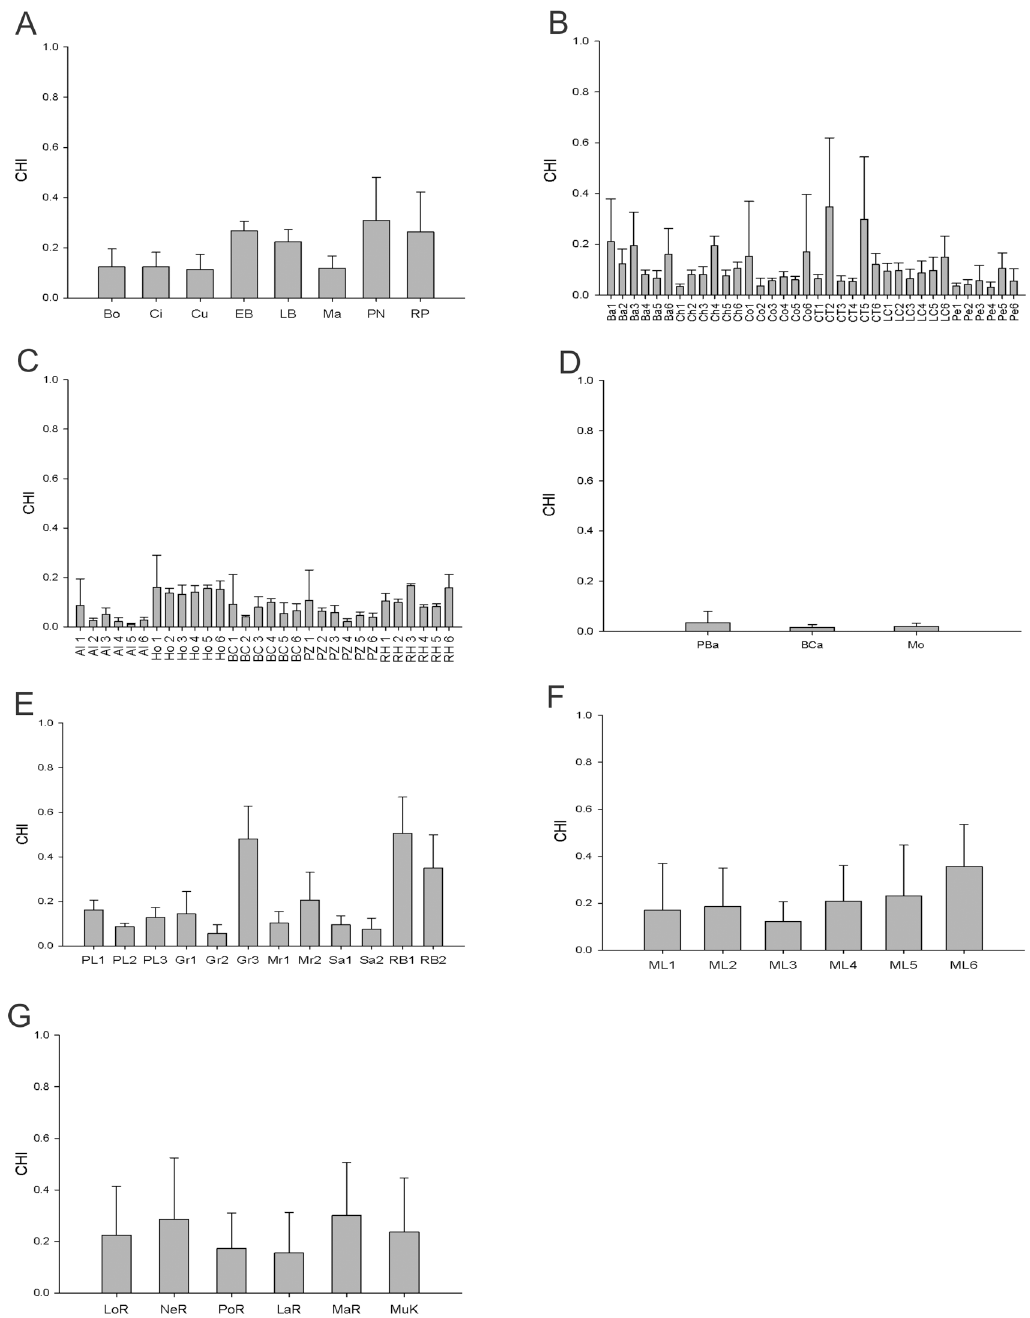
Fig 3. Coral reef health in sampling sites evaluated with CHI. a) Cancun: Bonanza (Bo), Chitales (Ci), Cuevones (Cu), El Bajito (EB), La Bocana (LB), Manchones (Ma), Punta Nizuc (PN), Radio Pirata (RP); b) Banco Chinchorro: Six sites for Baliza (Ba1, Ba2, Ba3, Ba4, Ba5, Ba6), six sites for Chancay (Ch1, Ch2, Ch3, Ch4, Ch5, Ch6), six sites for Colorados (Co1, Co2, Co3, Co4, Co5, Co6), six sites for Cueva Tiburones (CT1, CT2, CT3, CT4, CT5, CT6), six sites for La Caldera (LC1, LC2, LC3, LC4, LC5, LC6), and six sites for Penelope (Pe1, Pe2, Pe3, Pe4, Pe5, Pe6); c) Xcalak: six sites for Alejandro Reefs (Al1, Al2, Al3, Al4, Al5, Al6), six sites for Hobná (Ho1, Ho2, Ho3, Ho4, Ho5, Ho6), six sites for Bacalar Chico (Bac1, Bac2, Bac3, Bac4, Bac5, Bac6), six sites for Poza Rica (PZ1, PZ2, PZ3, PZ4, PZ5, PZ6), and six sites for Rio Huach (RH1, RH2, RH3, RH4, RH5, RH6); d) Punta Manabique: Piedra de la barracuda (PBA), Bajo del Cabo (BCA), Motaguilla (Mo); e) Cayos Cochinos: three sites for Pelicanos (PL1, PL2, PL3), three sites for Grupera (Gr1, Gr2, Gr3), two sites for Mariposales (Mr1, Mr2), two sites for Salamandinga (Sa1, Sa2), and two sites for Roatan Bank (RB1, RB2); f) Media Luna: six sites for Media Luna (ML1, ML2, ML3, ML4, ML5, ML6) and